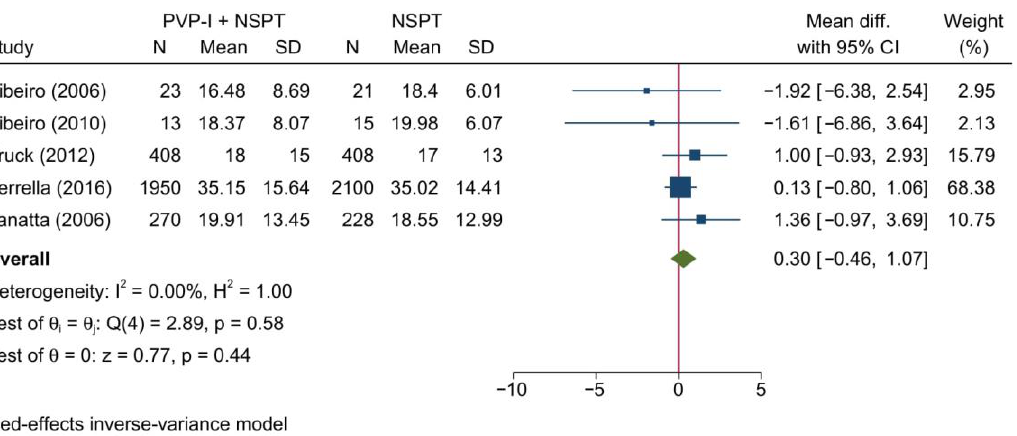
Figure 7. Forest plot showing the comparison between PVP-I + NSPT and NSPT alone regarding bleeding on probing (continuous variable) [31,34,43,44,46].